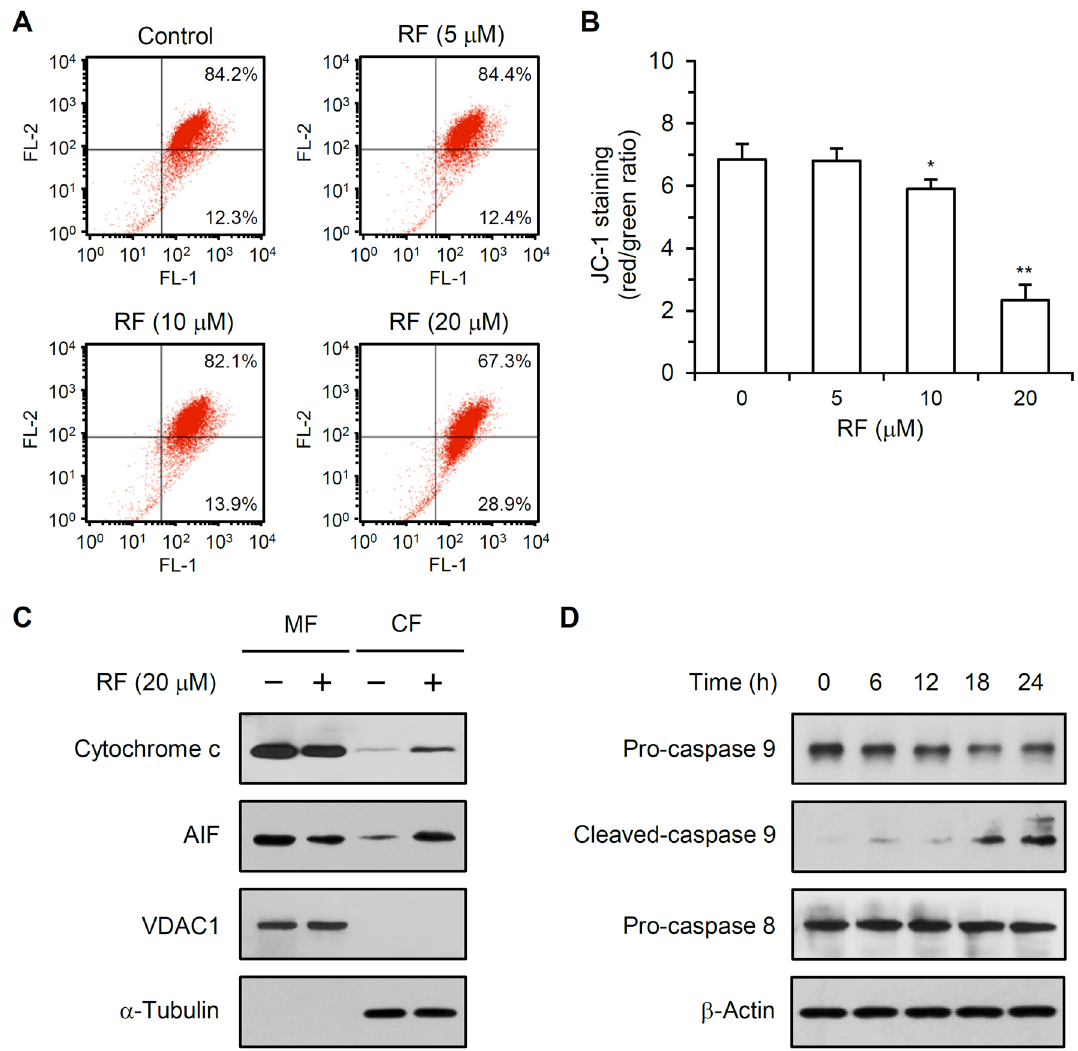
Figure 4. Effect of RF on the mitochondrial membrane potential and caspase 9 activation. ( A ) HUVECs were treated with different RF concentrations for 24 h, stained with JC-1, trypsinized, and resuspended in PBS. JC-1 fluorescence was measured at 530 nm (FL-1, green, monomeric form) and 590 nm (FL-2, red, aggregated form) by flow cytometry. ( B ) The ratio of aggregated JC-1 to monomeric JC-1 is shown. The data are presented as the mean ± SD of three independent experiments; * p < 0.05, ** p < 0.01, compared to the control. ( C ) Mitochondrial fraction and cytoplasmic fraction (MF and CF) were collected from 20 μM RF-treated HUVECs. Equal amounts of each fraction were separated by SDS-PAGE, and cytochrome c and AIF levels were detected by western blotting. VDAC1 and α-tubulin were detected as controls to ensure that the MF and CF were not cross-contaminated. ( D ) HUVECs were treated with 20 μM RF, total protein was extracted, and pro-caspase 9, cleaved-caspase 9, pro-caspase 8, and cleaved-caspase 8 levels were determined by western